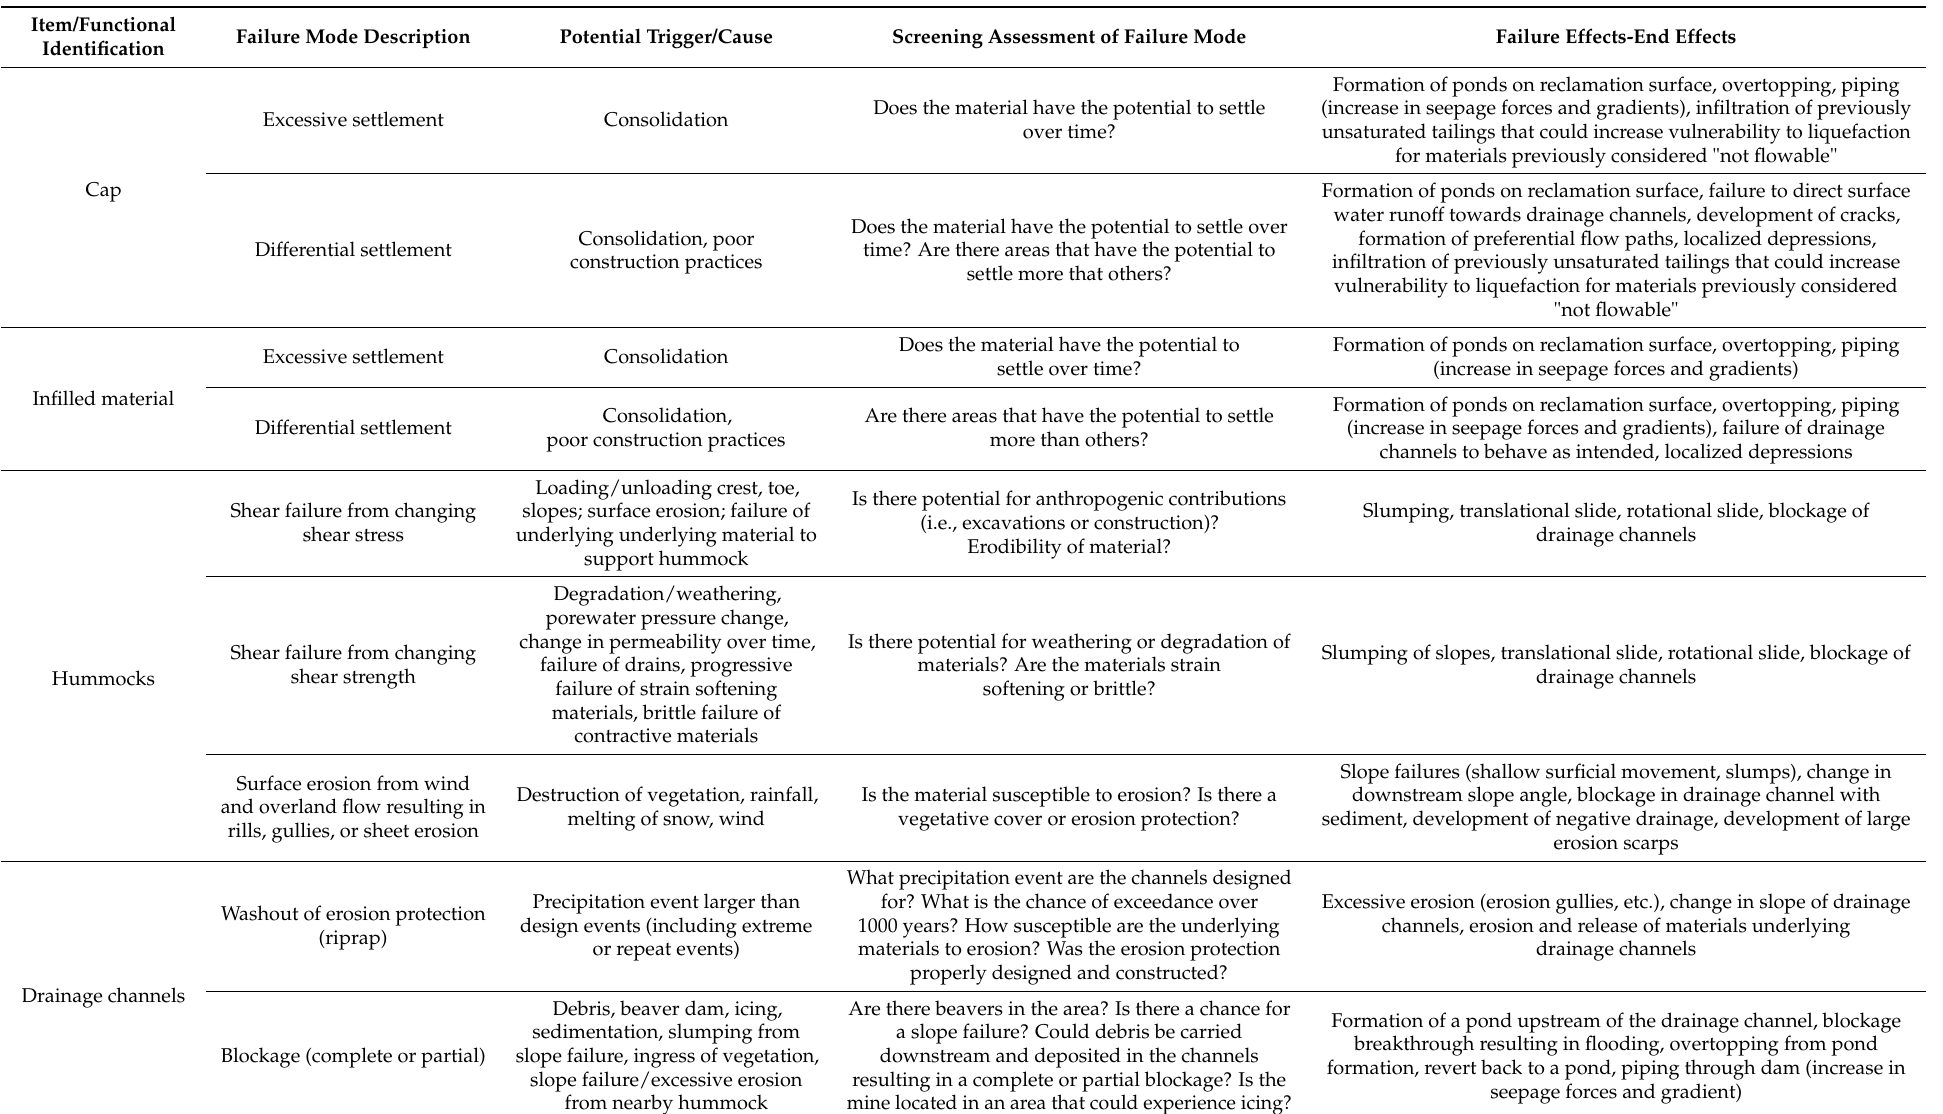
Table A4. Landform